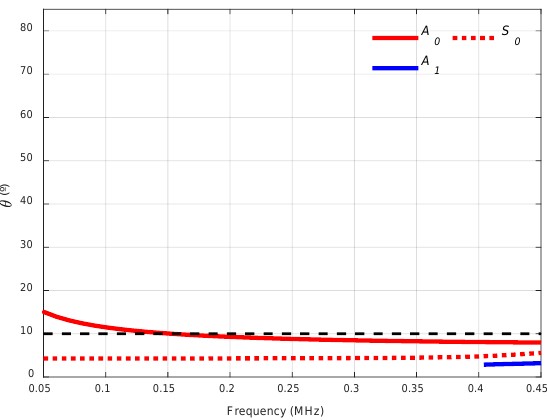
Figure 20. Incidence angle dispersion curves for a mortar plate and air as the coupling medium ( c = 343 m/s). The chosen angle (10°) is represented by a black discontinuous curve. In Figure 21, there is a good match between the theoretical and experimental curves. The A 0 mode is excited in the frequency range that shows the SSC , from 0.15 to 0.3